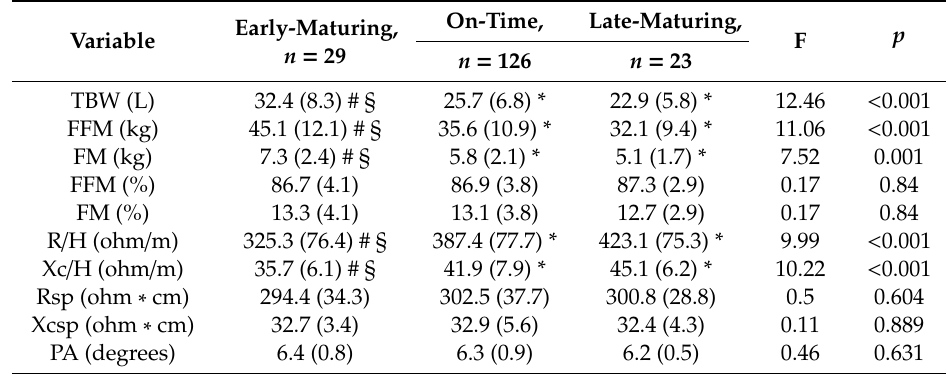
Table 2. Results of ANOVA analyses examining the di ff erences in body composition and physical performance, according to maturity